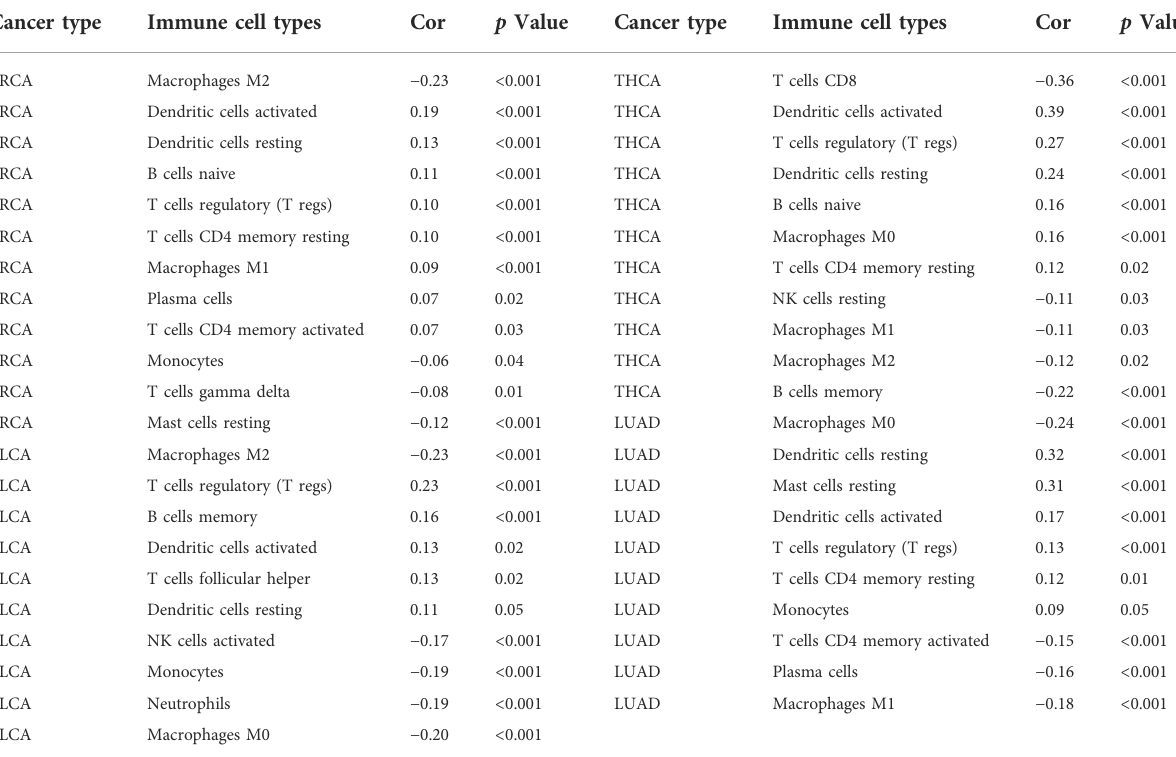
TABLE 2 Association of forkhead box Q1 expression with immune cell in fi